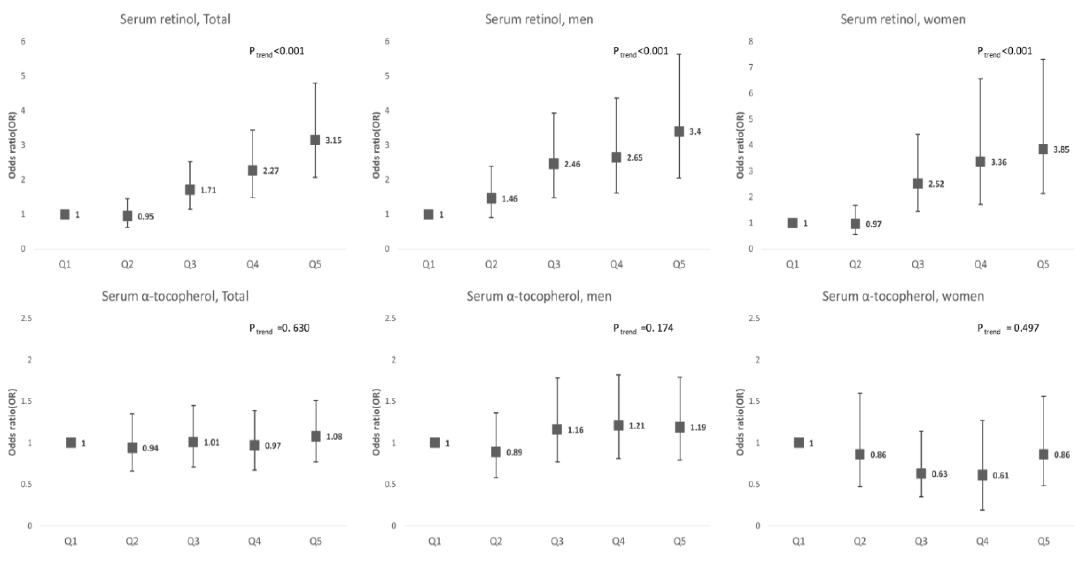
Figure 2. Association of serum retinol and α -tocopherol levels with hyperuricemia. Data are presented as odds ratio with 95% confidence intervals (error bars).